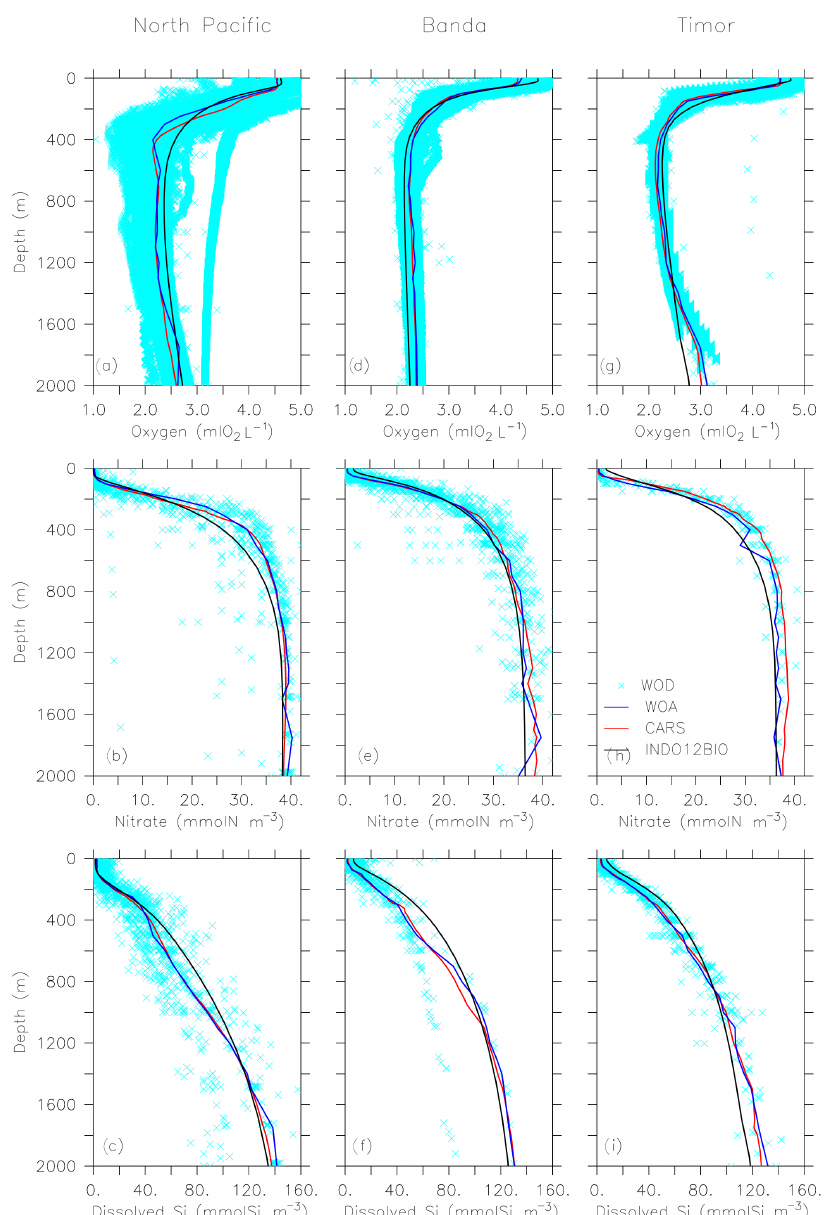
Figure 3. Vertical profiles of oxygen (mL O 2 L − 1 ; top: a , d , g ), nitrate (mmolNm − 3 ; middle: b , e , h ) and dissolved silica (mmolSim − 3 ; bottom: c , f , i ) in three key boxes for water masses transformation (North Pacific, left; Banda, middle; and Timor, right) (see Fig. 2; Koch- Larrouy et al., 2007). CARS and WOA annual climatologies are in red and dark blue. INDO12BIO simulation averaged between 2010 and 2014 is in black. All the raw data available on each box and gathered in the WOD (light blue crosses) are added in order to illustrate the spread of